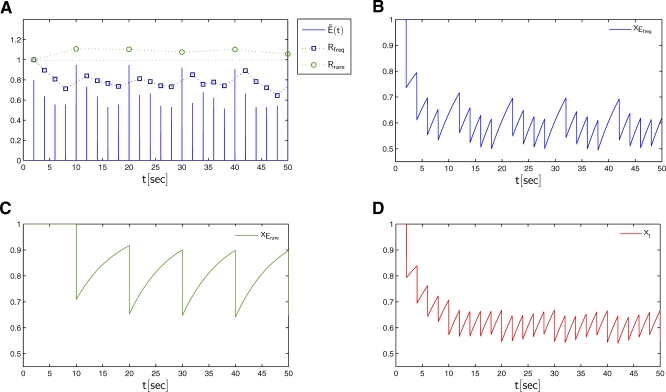
Dual Site Stimulation Dynamics in Simulated Networks(A) Network response to rare (circles) and frequent (squares) stimulation. Stimulation ratio was 4:1 (β = 0.2) at 0.5 s−1.(B) The average excitatory synaptic availability at the frequent site.(C) The average excitatory synaptic availability at the rare site.(D) The average synaptic availability of the global inhibitory population.